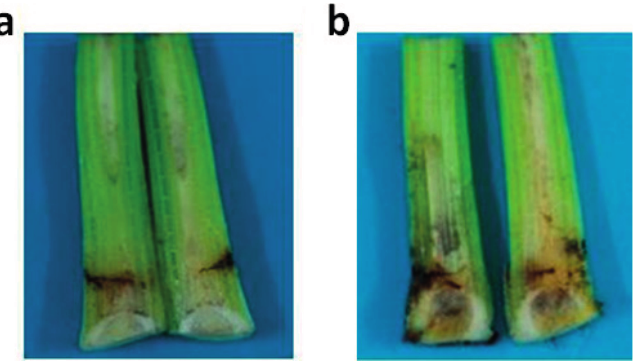
Figure 6. Tissue necrosis analysis of Cavendish banana stem. ( a ) Plants injected with r-FOC1-PGC3; ( b ) Plants injected with r-FOC4-PGC3. Each plant was injected with 1 U